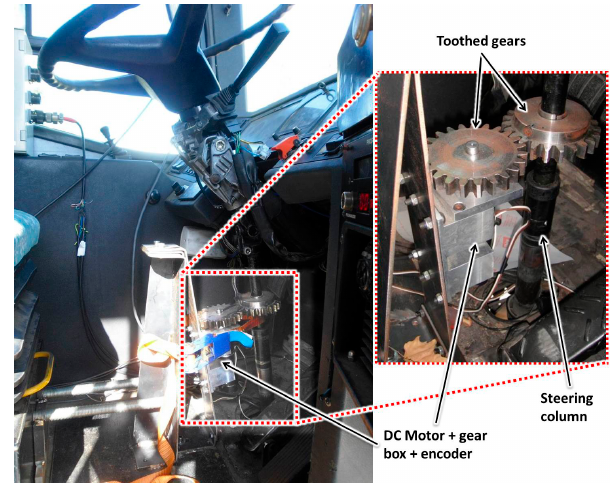
Figure 5. Actuator assembly for driving the steering wheel.